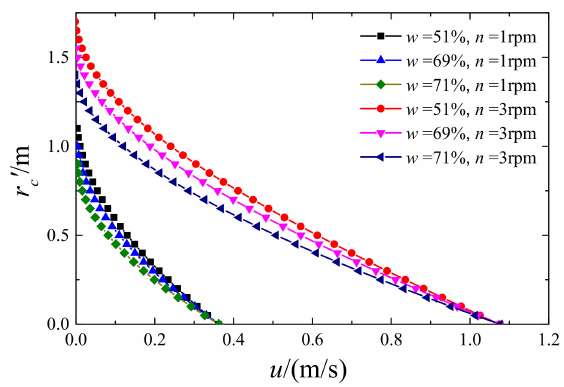
Figure 8. Velocity distribution curves lateral to the cutter